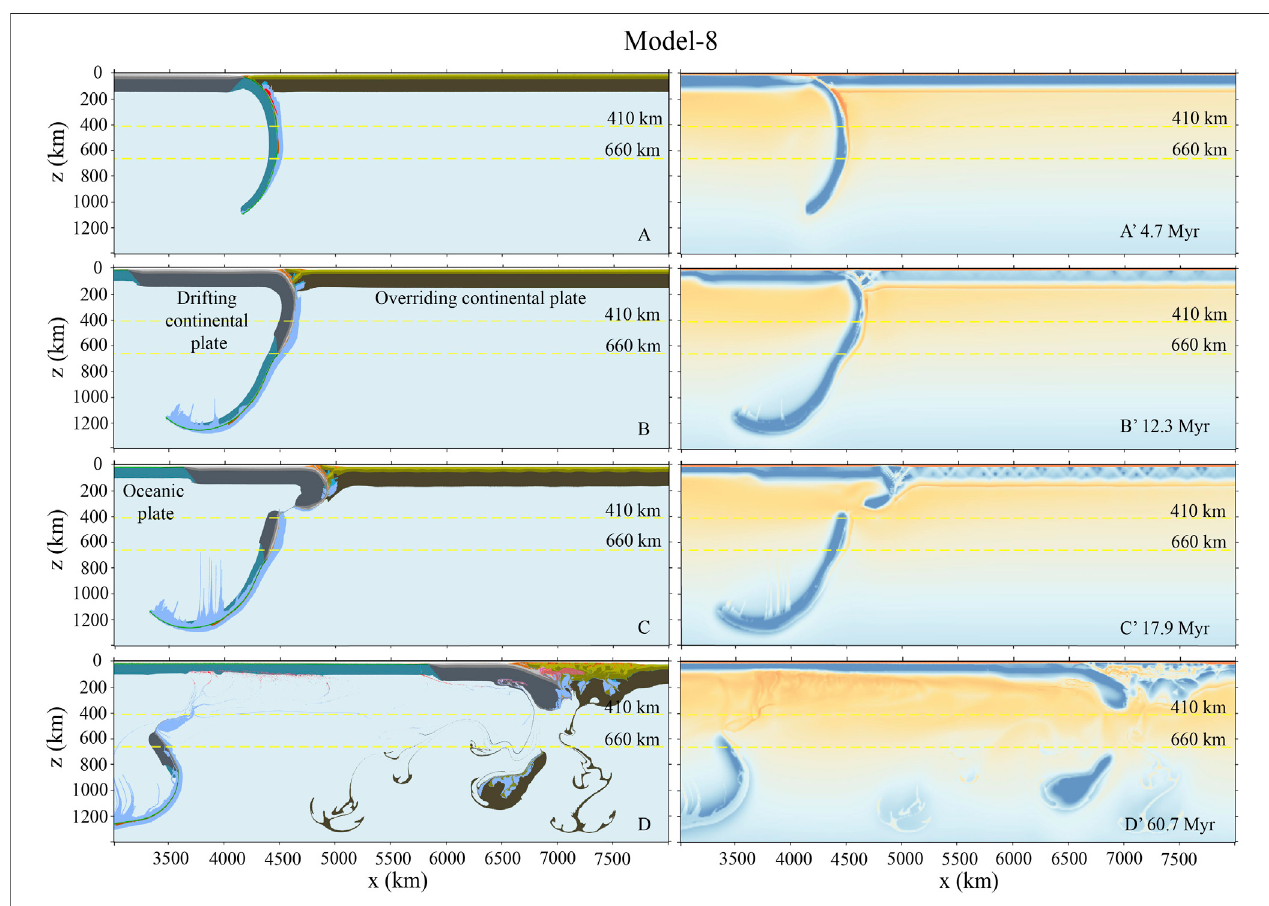
FIGURE 10 | Model-8 evolution with a further decreased plastic friction coef fi cient of the overriding lithospheric mantle, which is initially λ · sin ( φ ) (cid:2) 0.1 and will decrease linearly to 0.01 with the accumulated plastic strain to ε plas = 1 ( Supplementary Table S2 and Supplementary Equation S11 in the supporting information). All the other parameters are identical to Model-7 ( Figure 9 ). (A – D) The composition fi eld evolution with the corresponding colorbar is shown in Figure 2A . (A ’ – D ’ ) The effective viscosity evolution with the corresponding colorbar is shown in Figure 2B